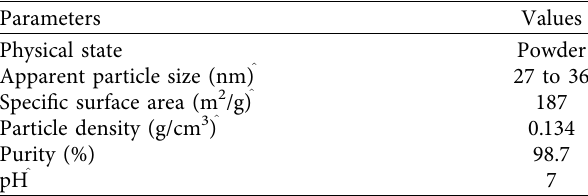
Table 6: Physical properties of nano-SiO